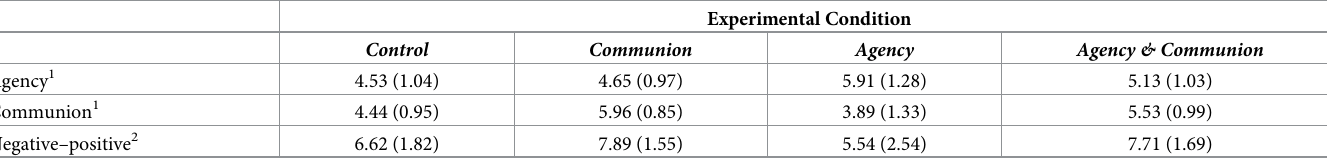
Table 4. Means and standard deviations for manipulation check and perception of prototypes in experimental conditions (Experiment